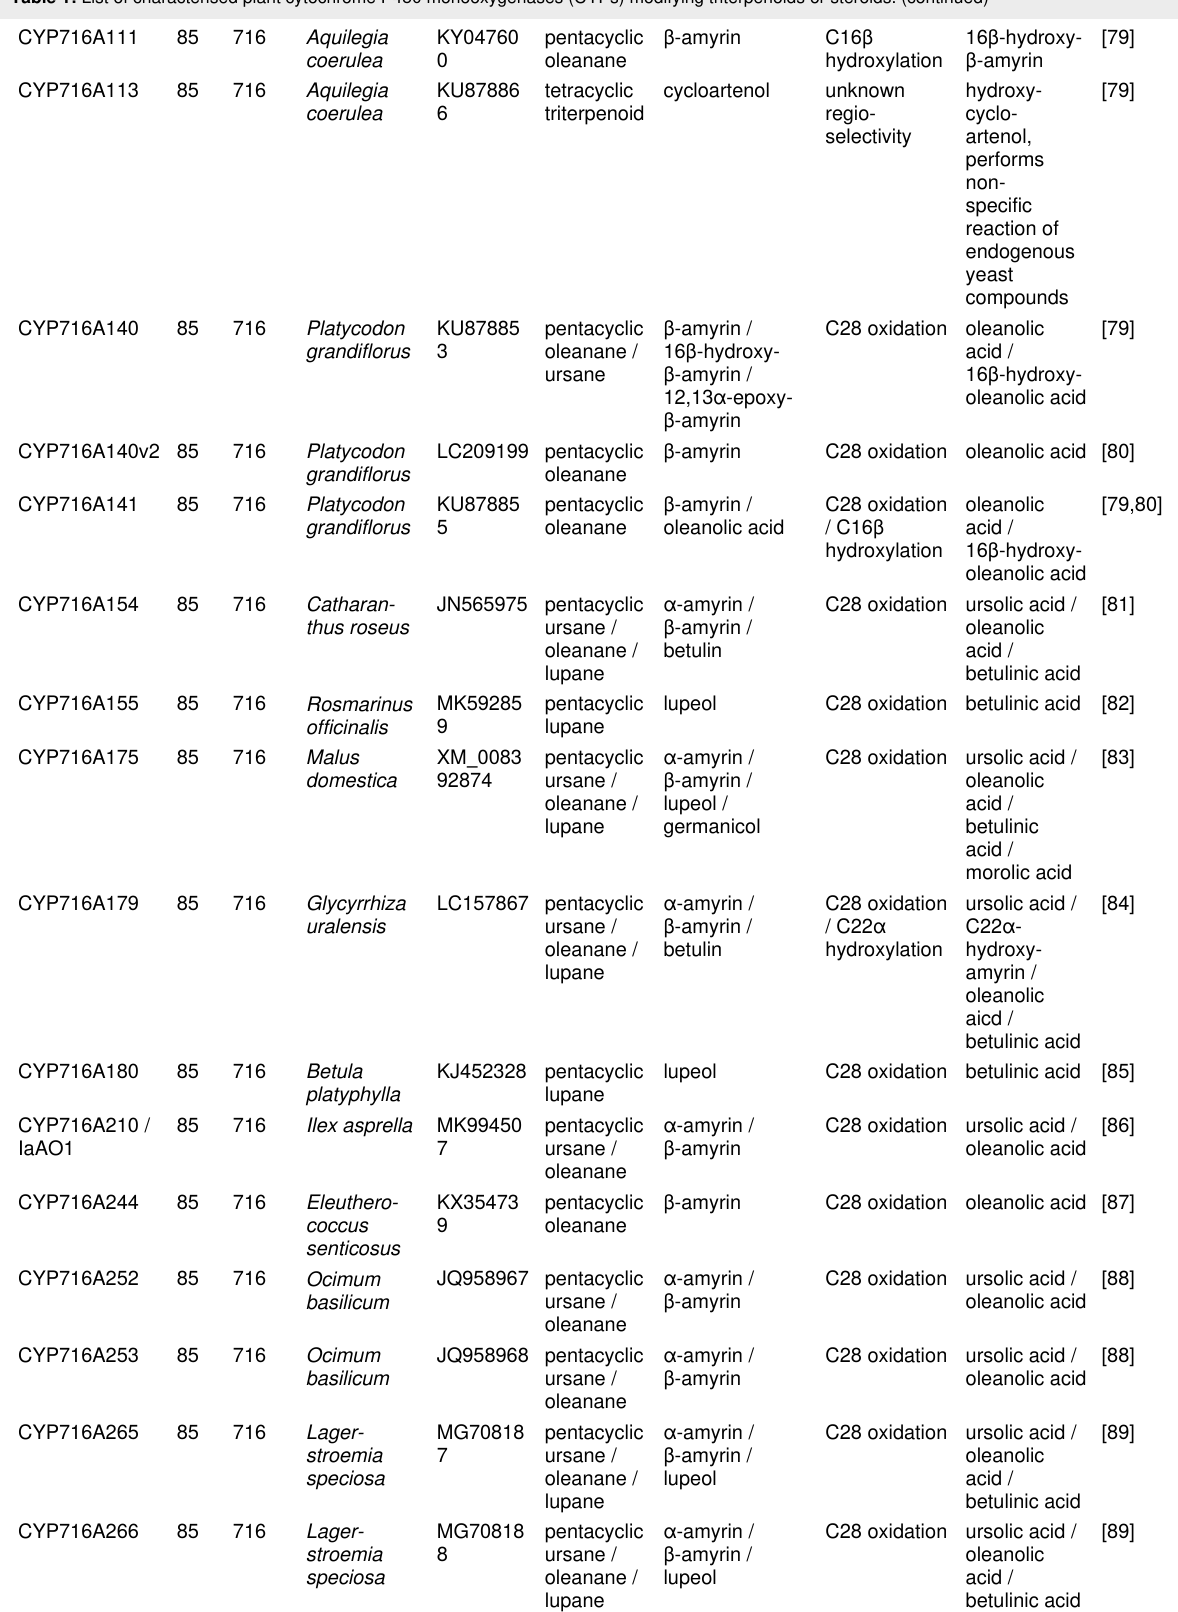
Table 1: List of characterised plant cytochrome P450 monooxygenases (CYPs) modifying triterpenoids or steroids. (continued)